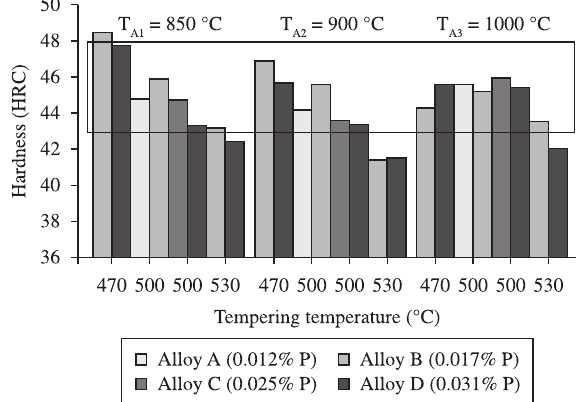
, TA , and TA ). 1 2 3